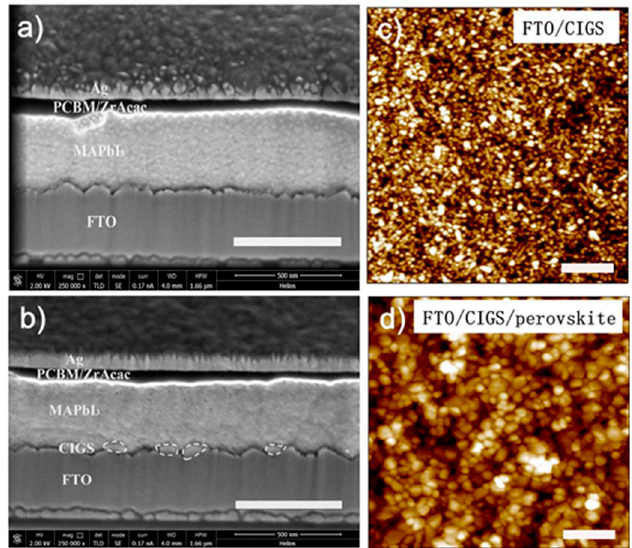
Figure 1. ( a ) Cross-section SEM image of the perovskite device without HTL layer. ( b ) Cross-section SEM image of the CIGS-based perovskite device. The scale bar is 500 nm. AFM images of the CIGS film ( c ) and the perovskite film on CIGS ( d ), respectively. The AFM image sizes are 5 µm × 5 µm and the scale bar is 1 µm.